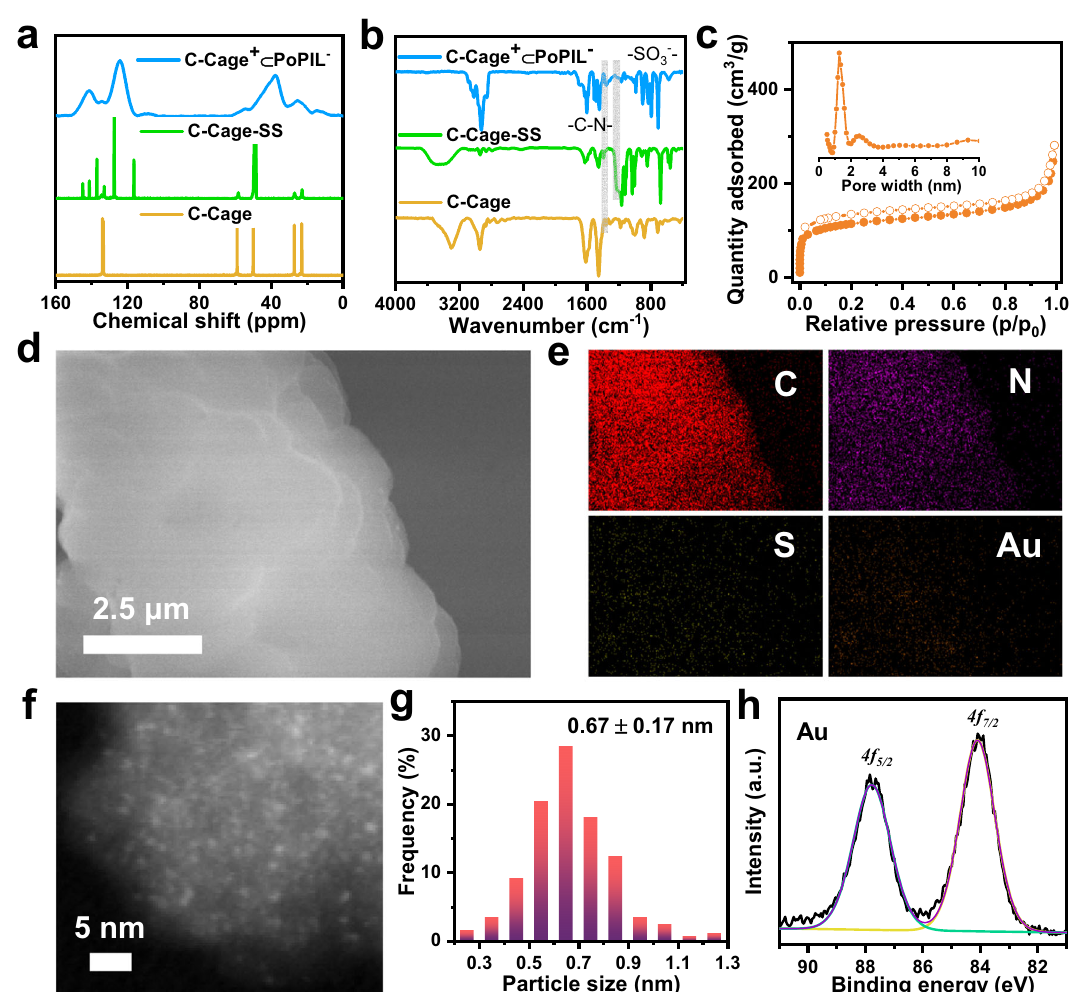
Fig. 2 Structure characterization of the supramolecular assemblies and host-in-host composites. a 13 C NMR spectra and ( b ) FT-IR spectra of the C-Cage (yellow), C-Cage-SS (green) and C-Cage + ⊂ PoPIL − (blue), ( c ) N 2 sorption isotherms and the NLDFT pore size distribution plot (inset) of the C-Cage + ⊂ PoPIL − , ( d ) SEM image and ( e ) elemental mapping images of the [Au ⊂ C-Cage + ] ⊂ PoPIL − , scale bar: 2.5 μ m, carbon element (red), nitrogen element (purple), sulfur element (gray), gold element (orange), ( f ) HAADF-STEM image of the Au clusters uniformly dispersed in the [Au ⊂ C-Cage + ] ⊂ PoPIL − matrix, scale bar: 5nm, ( g ) statistic size distribution histogram of Au clusters (data calculated from 210 counts), ( h ) XPS spectrum of [Au ⊂ C-Cage + ] ⊂ PoPIL − showing Au 4f 7/2 and 4f 5/2 peaks of metallic